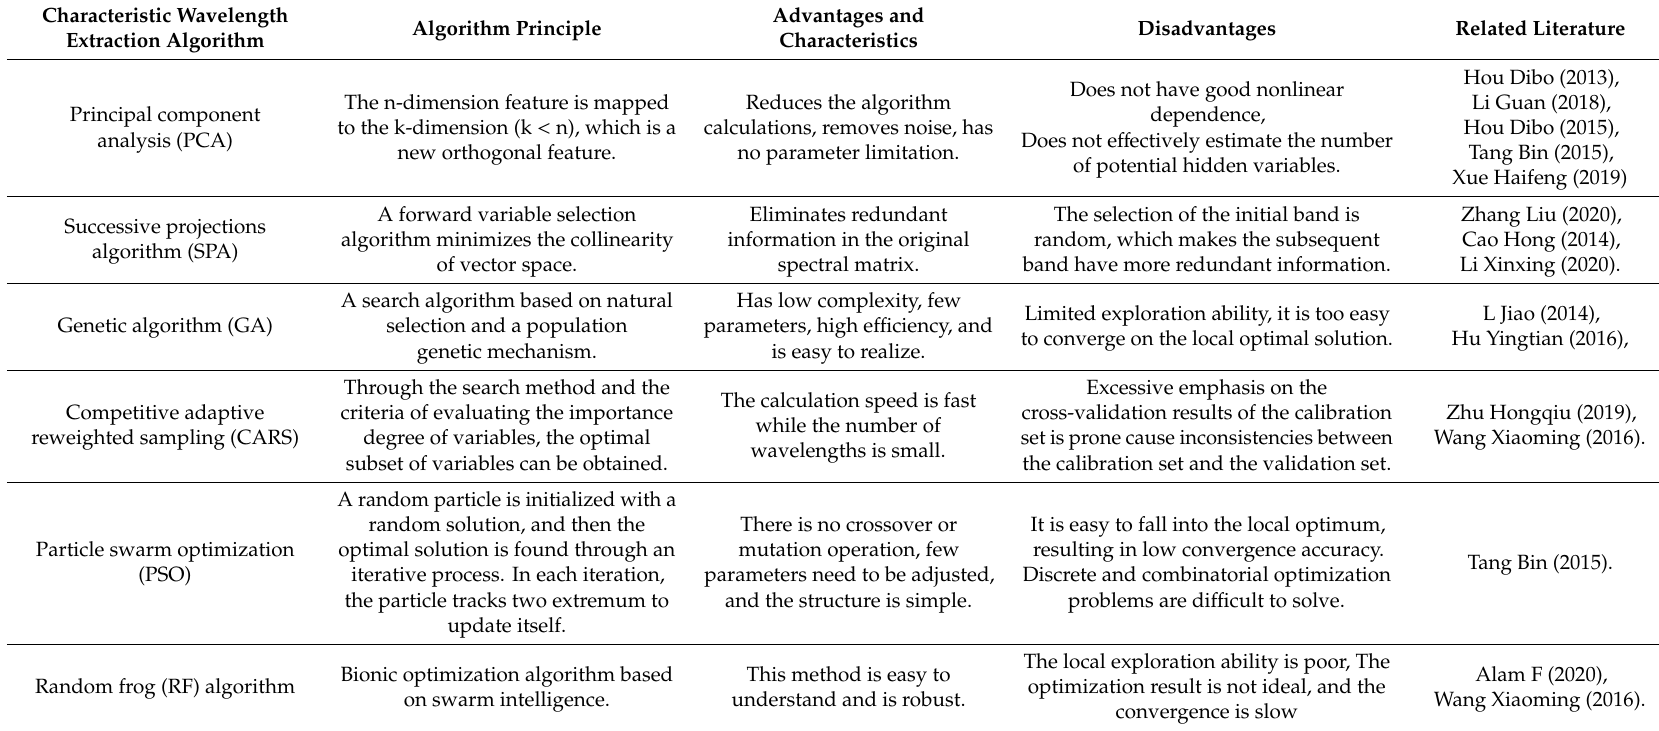
Table 3. Algorithms for characteristic wavelength extraction of spectral